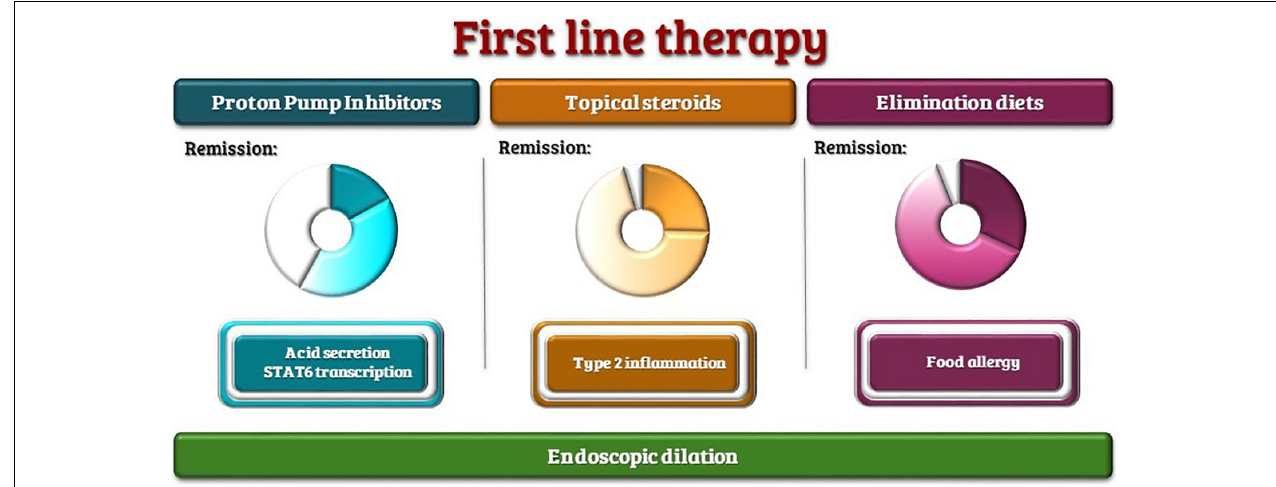
FIGURE 2 | First-line therapies with the range of reported remission rates and therapeutic targets.